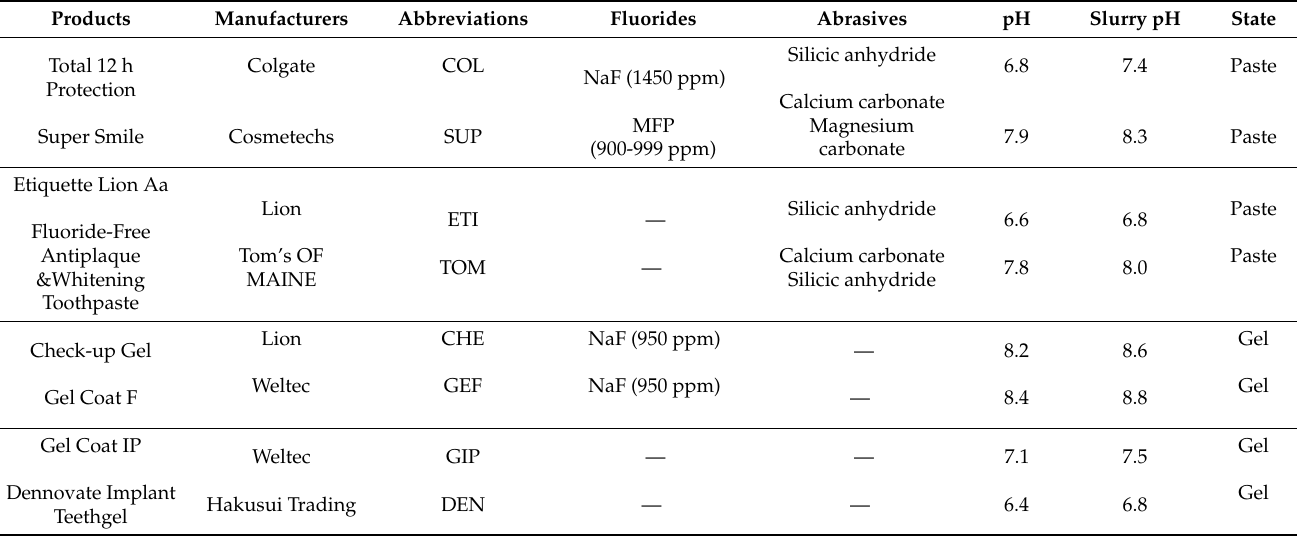
Table 1. Toothpastes used in the present